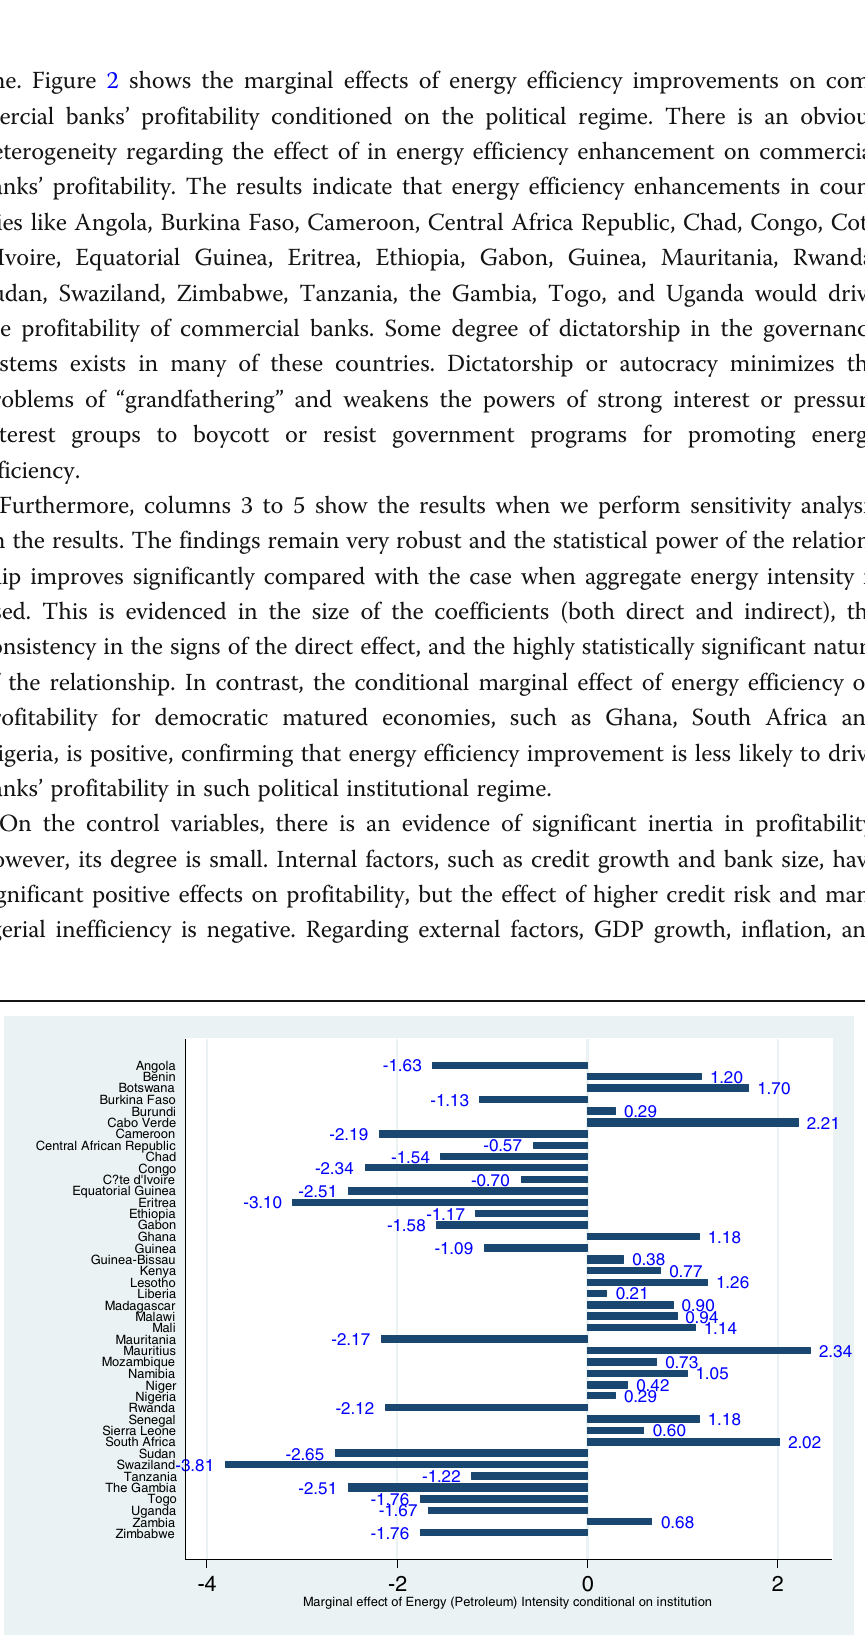
Fig. 2 The country-specific marginal effect of petroleum energy intensity conditioned on political